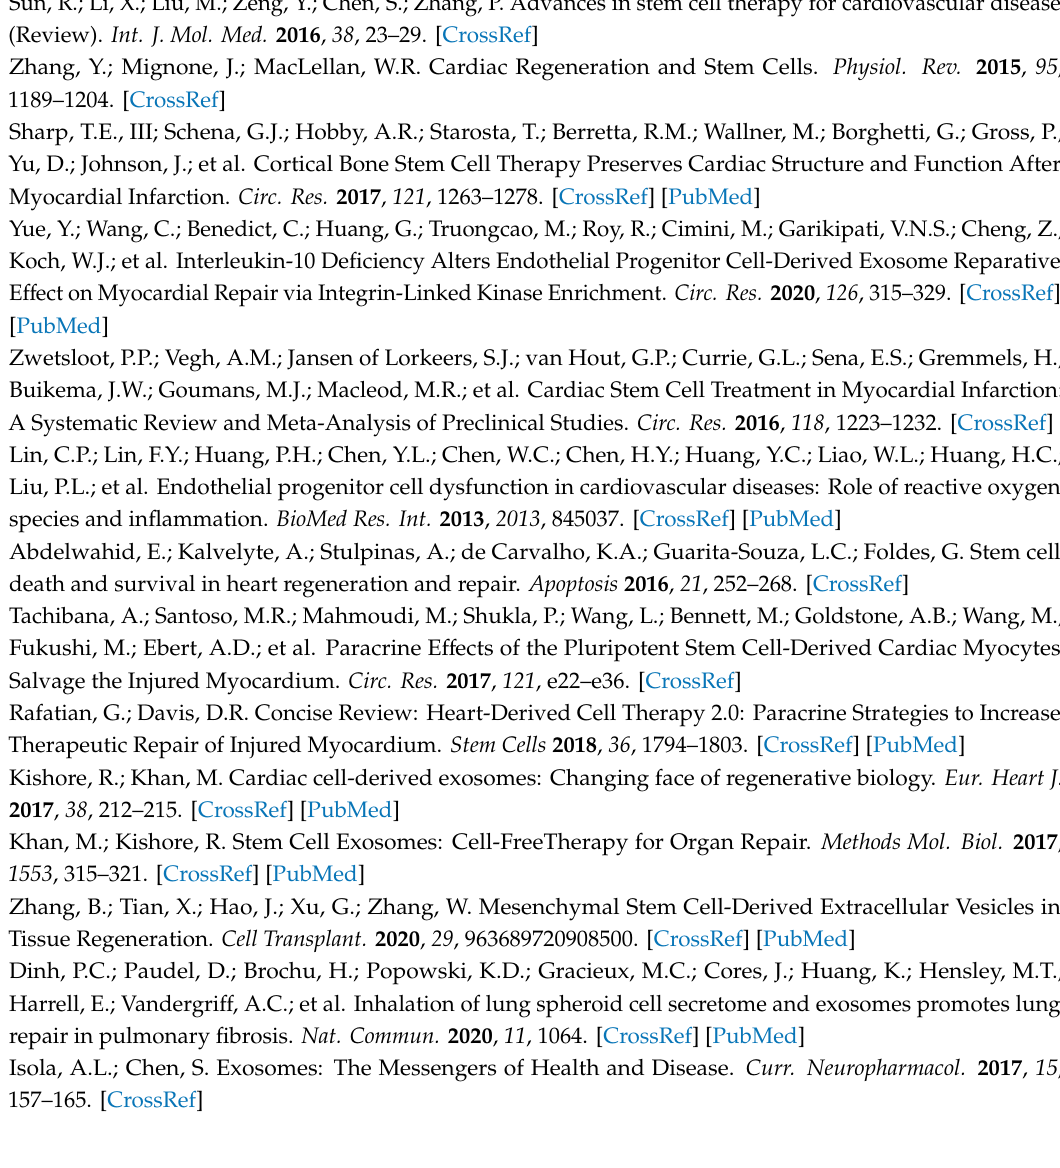
Supplementary Table S1: Total reads and read number of each RNA category. Supplementary Table S2: Di ff erential expressed 324 genes. Supplementary Table S3: IPA analysis for potential signaling pathways and genes. Supplementary Table S4: Prediction of miRNA-targeted mRNAs. Supplementary Table S5: Predicted di ff erentially expressed targets in